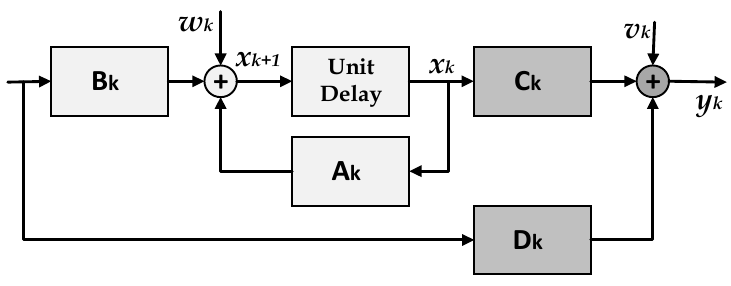
Figure 1. Linear discrete-time system from Equations (1) and (2).